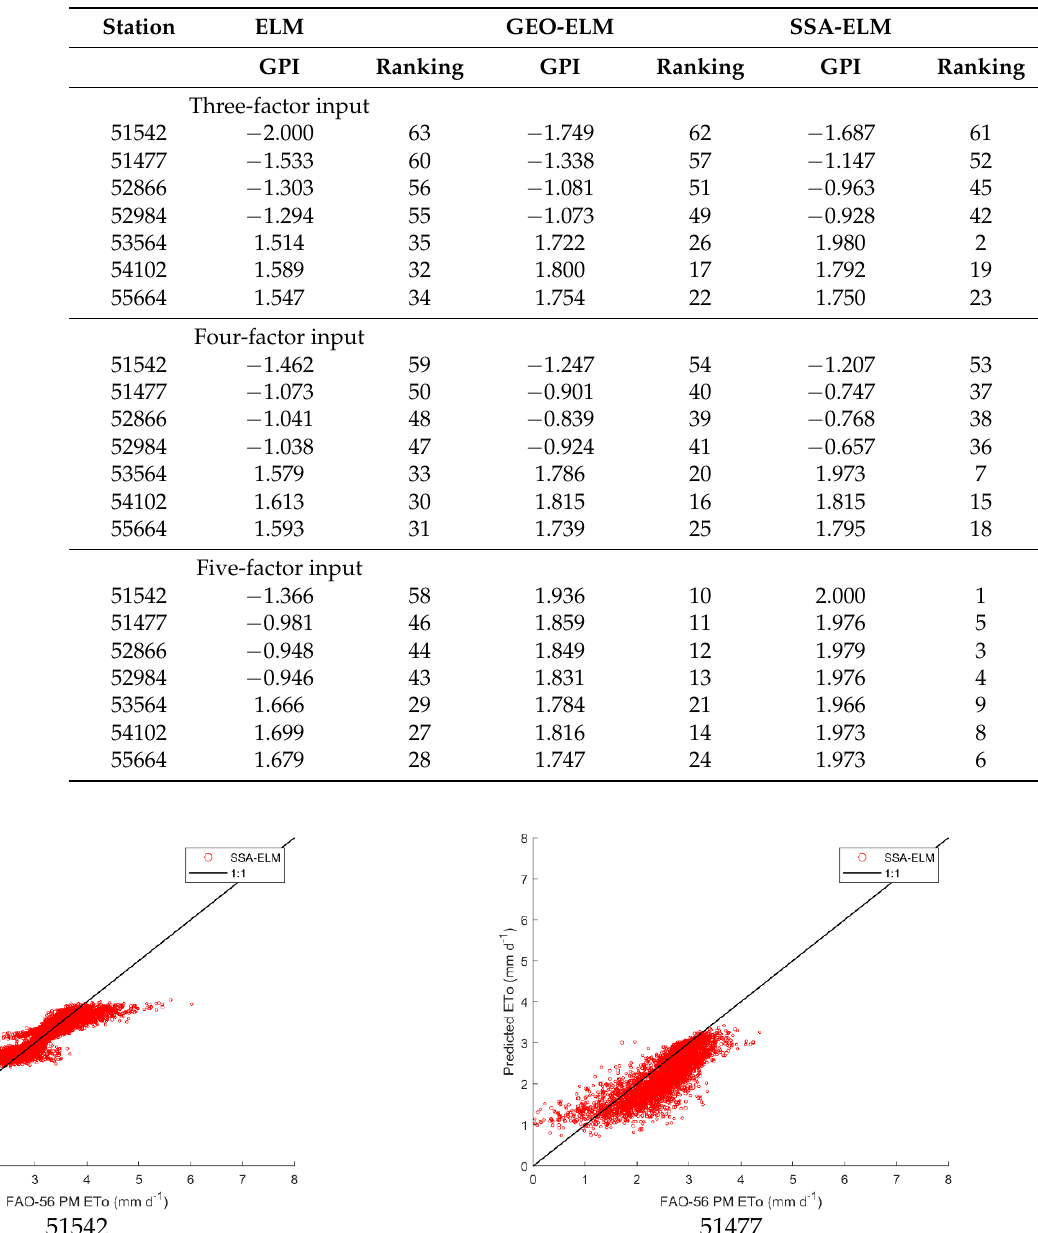
Table 3. GPI value and ranking of the three ET O models. Station ELM GEO-ELM SSA-ELM GPI Ranking GPI Ranking GPI Ranking Three-factor input 51542 − 2.000